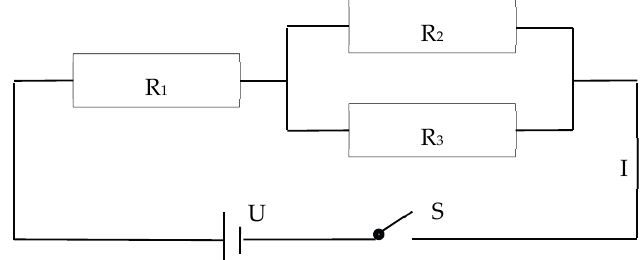
Figure 3. Map of the structure of a series and parallel circuit.